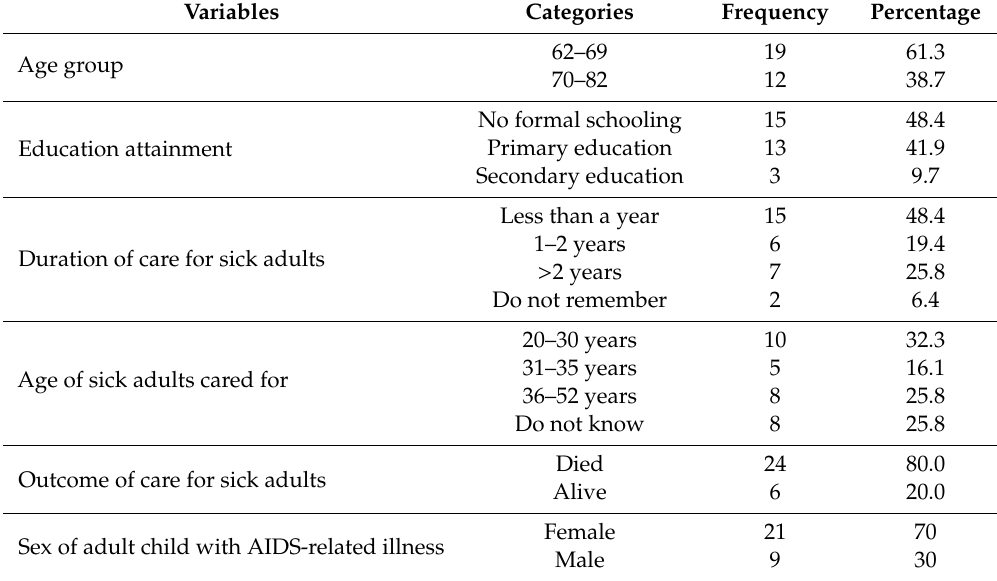
Table 1. Sociodemographic, health and caring characteristics of older